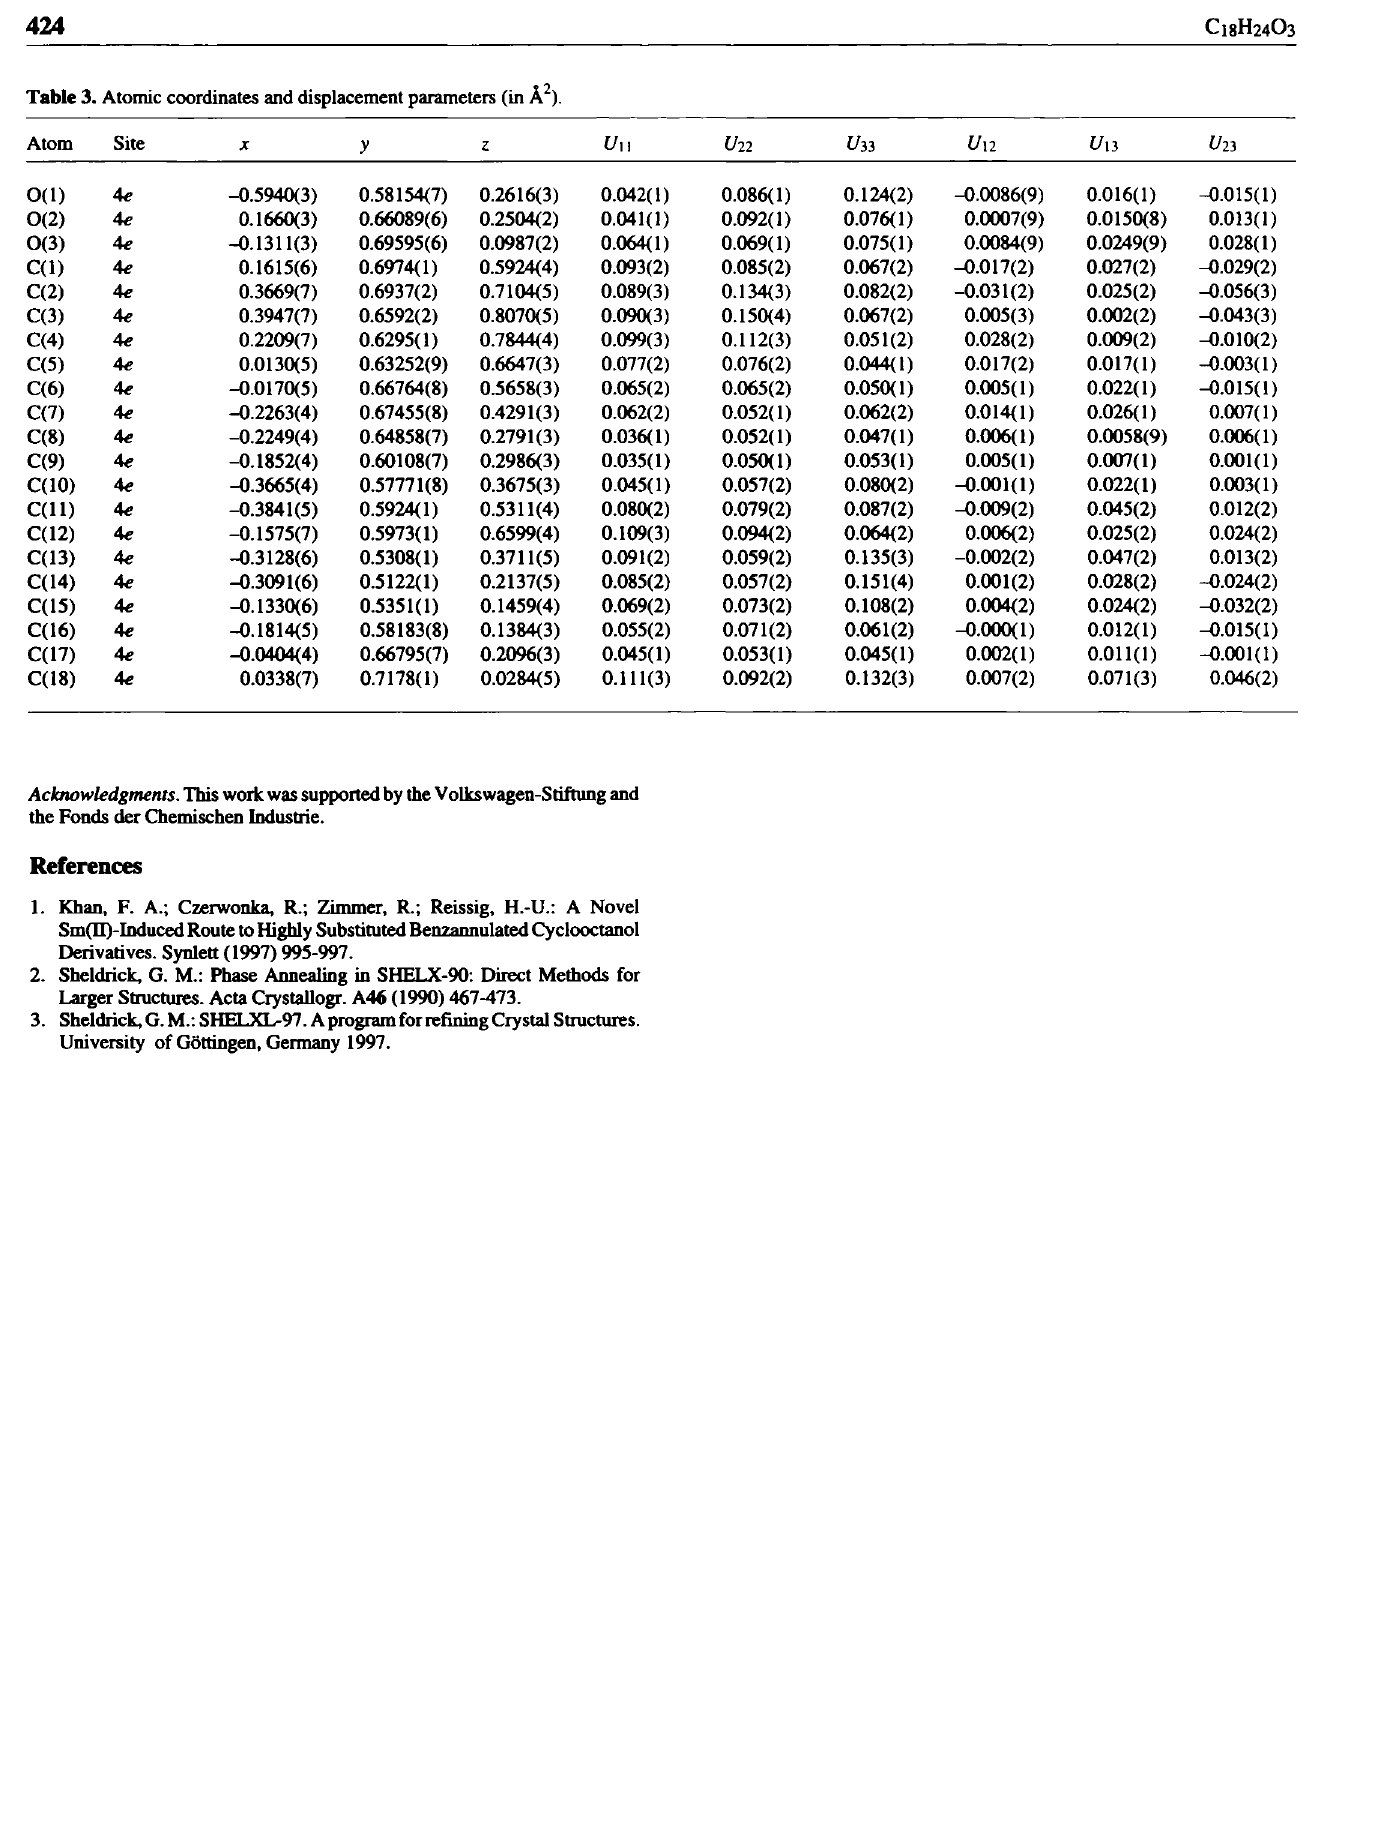
Table 3. Atomic coordinates and displacement parameters (in Â 2